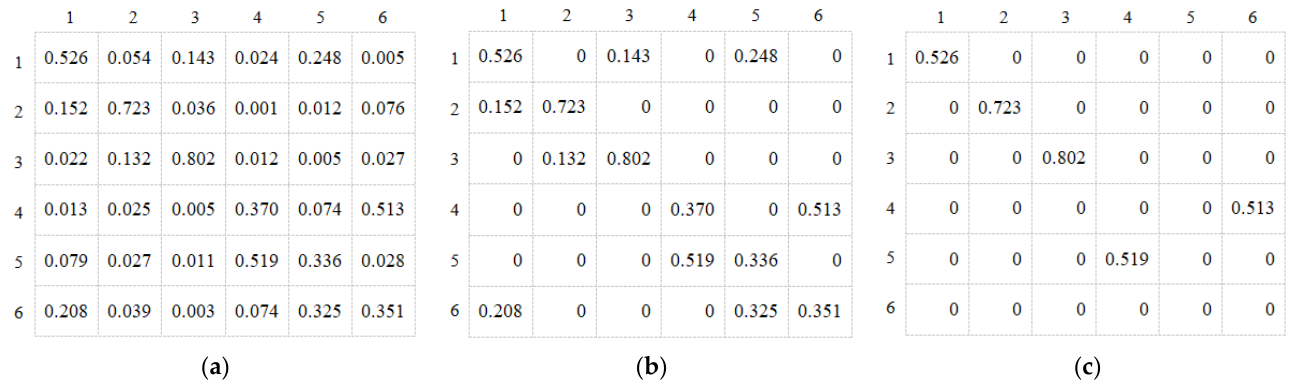
Figure 4. Spatial interaction matrices of different spatial sparsity ( 𝛾 ). ( a ) Spatial interaction matrix for 𝛾 = 0 ; ( b ) Spares spatial interaction matrix for 𝛾 = 0.1 ; ( c ) Spares spatial interaction matrix for 𝛾 = 0.5 .